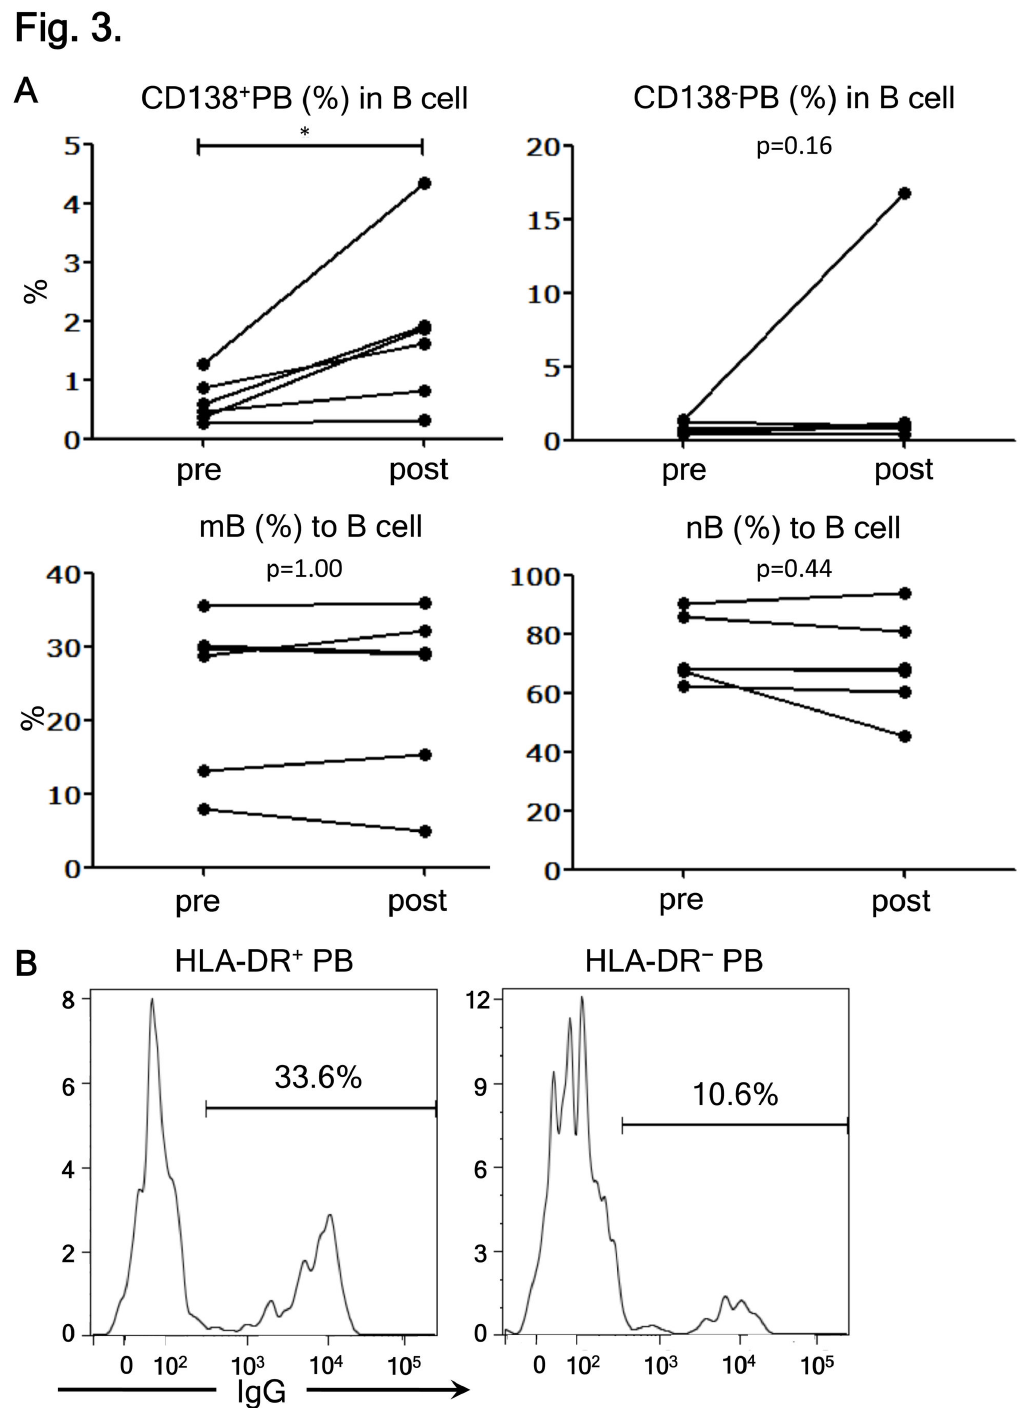
Figure 3. CD138 + HLA-DR + plasmablasts (PB) cells are recently differentiated IgG-producing PB. (A) The effects of influenza vaccination on the frequencies of B-cell subpopulations were analyzed. The frequency of each B-cell subpopulation derived from the peripheral blood of healthy subjects before (pre) and seven days after vaccination (post) is shown. Each line connects the values obtained from a single subject (*p < 0.05 by Wilcoxon signed rank test). (B) The results of intracellular IgG staining of HLA-DR + PB (left) and HLA-DR - PBs (right) are shown. The values represent the percentages of IgG-producing cells in each PB subpopulation. Representative data of one out of three individuals are displayed. doi: 10.1371/journal.pone.0083036.g003 PLOS ONE |